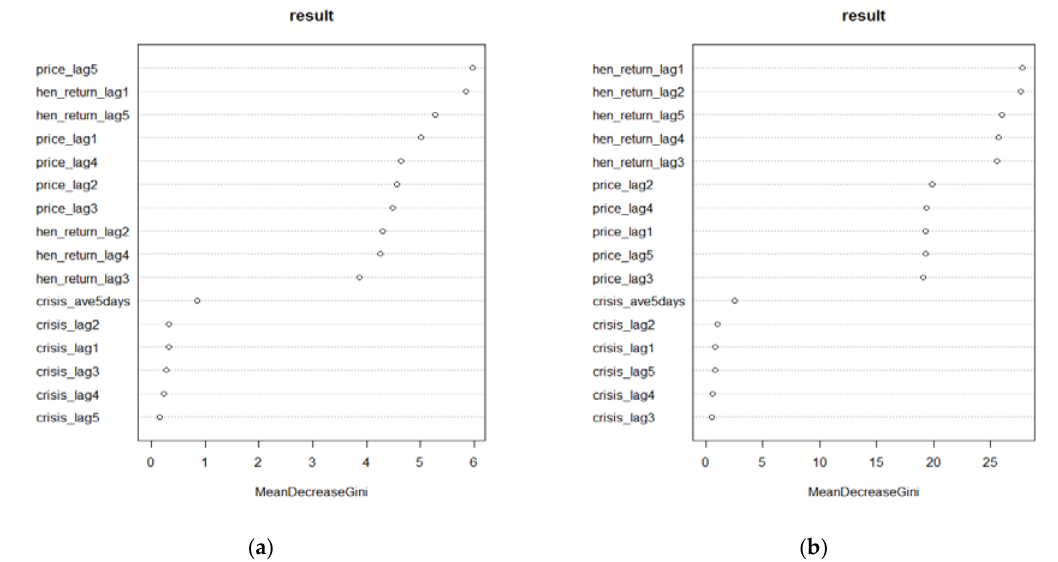
Figure A5. RF variable importance plots: partial variables with the moving window and the expanding